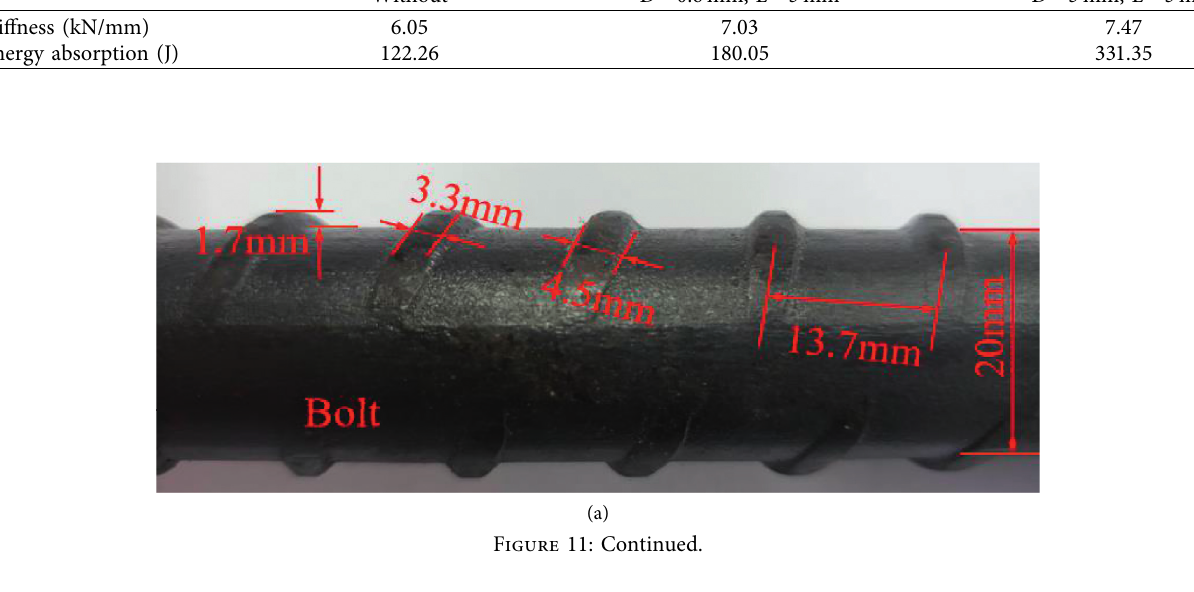
Table 3: The stiffness and energy absorption of different types of the anchorage systems. Evaluation indicator